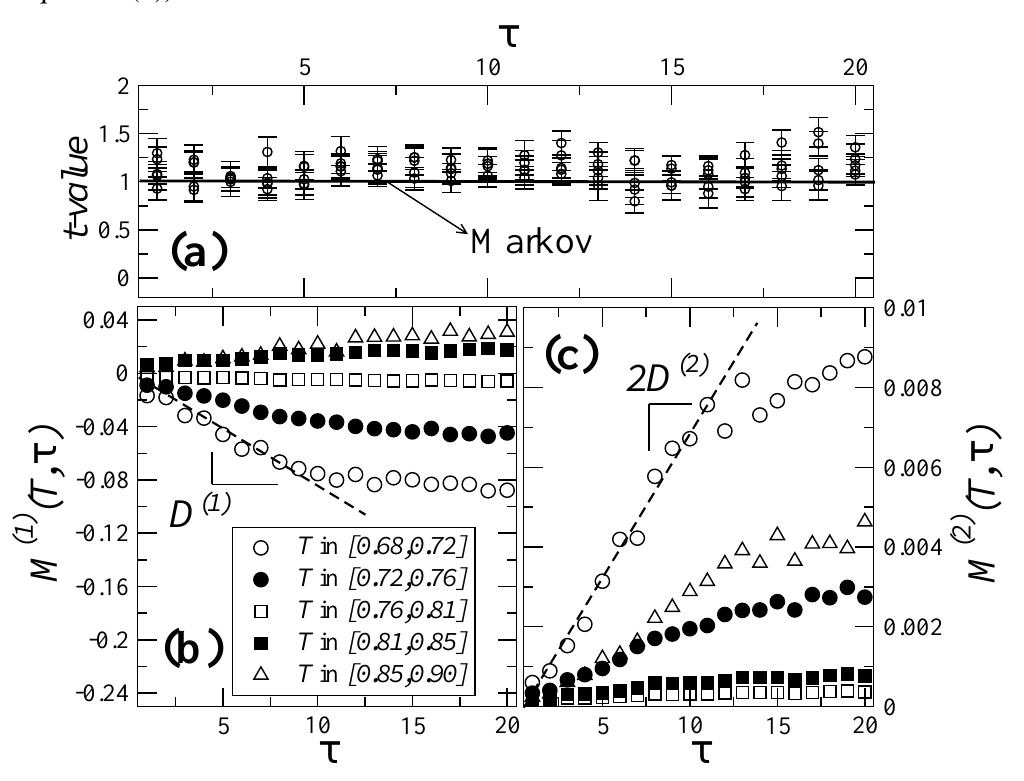
Figure 4. The Markov–Wilcoxon test retrieves a normalized t -value. When equal to one (solid line), the t -value indicates perfect matching between two conditional probability distributions. ( a ) In the load series conditioned to wind velocity values, the Markov condition is not perfectly fulfilled, but the method is still able to reproduce the torque time series and fatigue estimates. For those estimates one starts by computing ( b ) the first and ( c ) the second conditional moments, as defined in Equation (8). As indicated with dashed lines, the slope of a linear interpolation of M (1) and M (2) yields the drift and diffusion coefficients (see Equation